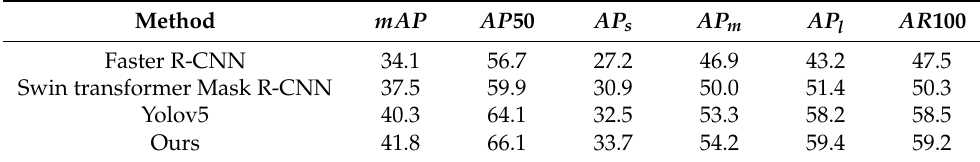
Table 1. Experimental results of each algorithm on the Visdrone2019 validation set.